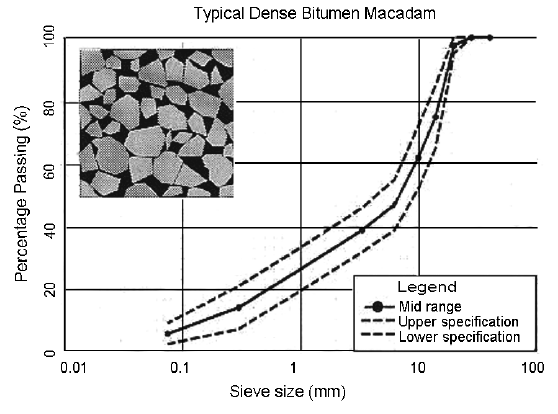
Fig. 2. A typical grading and cross section of a 20 mm DBM